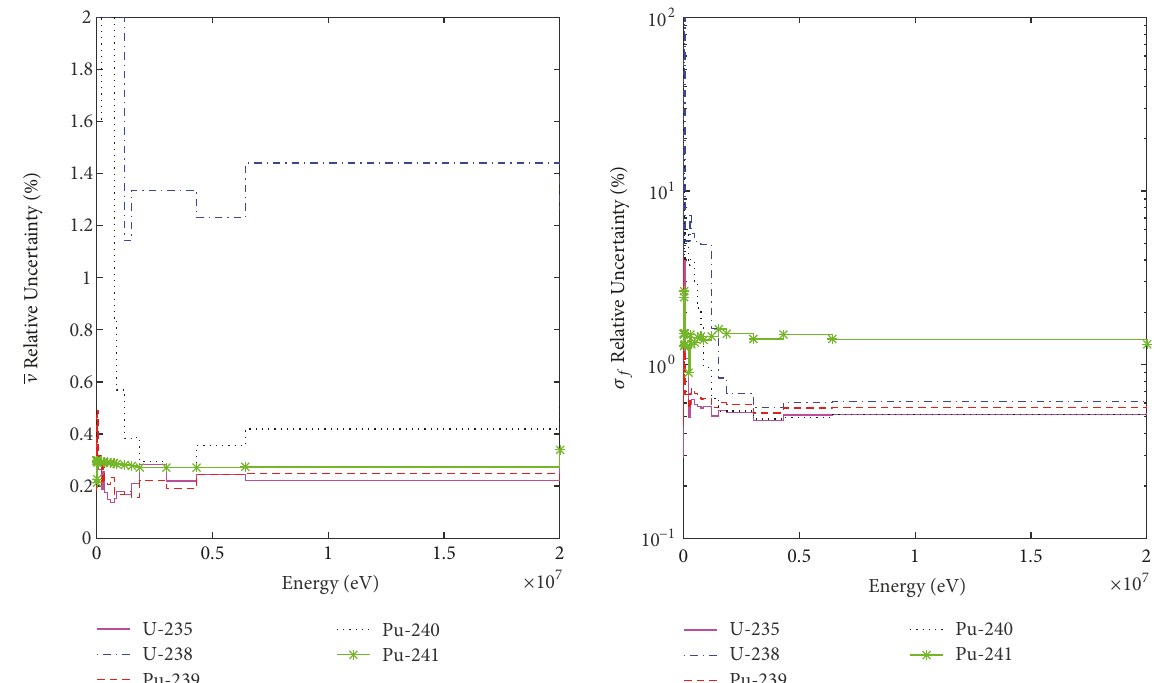
Figure 1: The uncertainty in ] (left) and fission cross-section (right) based on the 56-group covariance library in the SCALE code